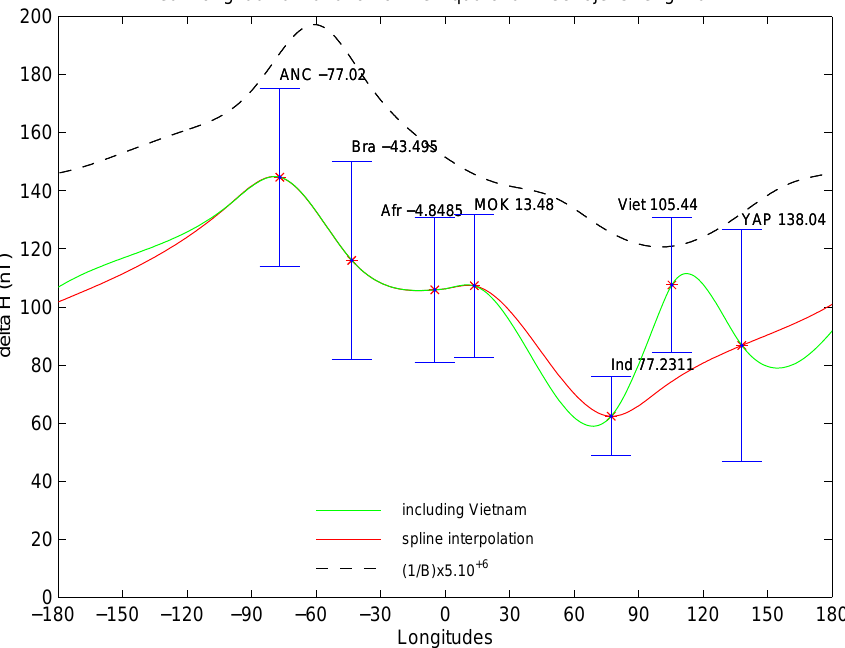
Fig. 4. The mean longitudinal variation of the EEJ magnetic effects (solid lines) from IEEY ground-based magnetic data at 12h, and the inverse of the main field 1/B exaggerated 5 × 10 6 times (dashed line). The green line (same as in Fig. 3) represents the ground-based longitudinal variation of the EEJ magnetic effects at 12 H , including data from Baclieu (Vietnam), while the red curve does not take data from Baclieu into account. The error bars represent the standard deviations of 1H . The curve 1/B is obtained at regular interval in